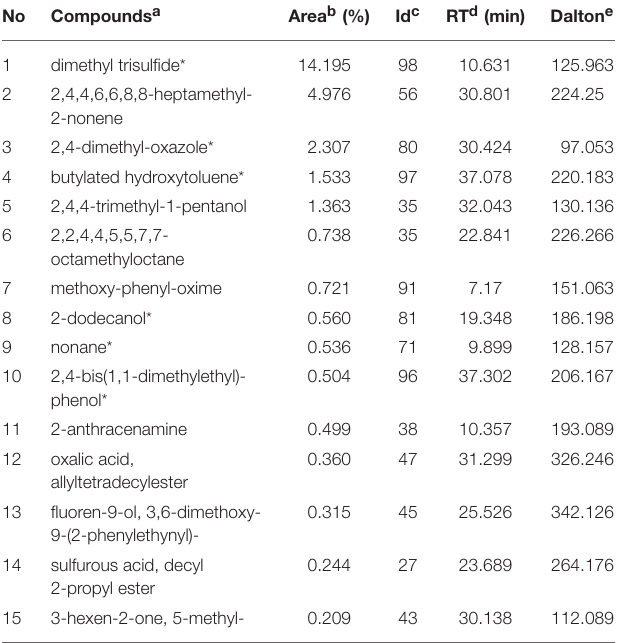
TABLE 1 | GC-MS analysis of volatile organic compounds emitted by strain